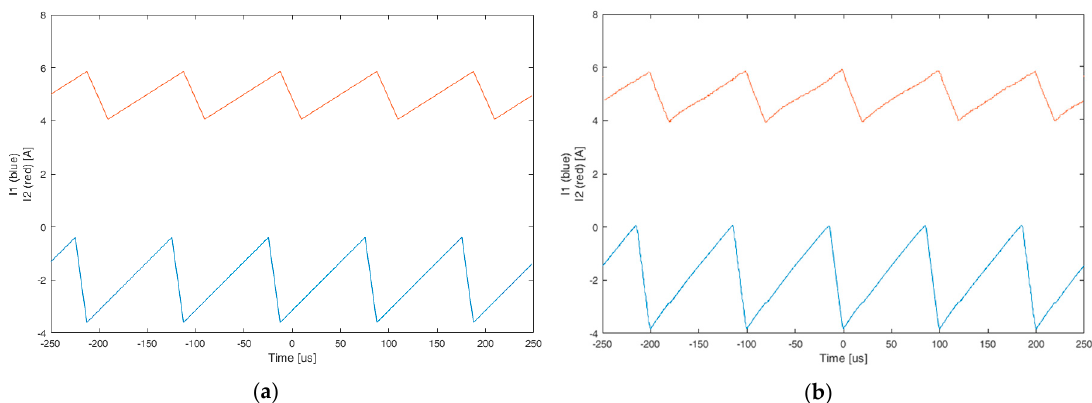
Figure 14. Current waveforms in Test 3 ( a ) simulation ( b ) experimental.